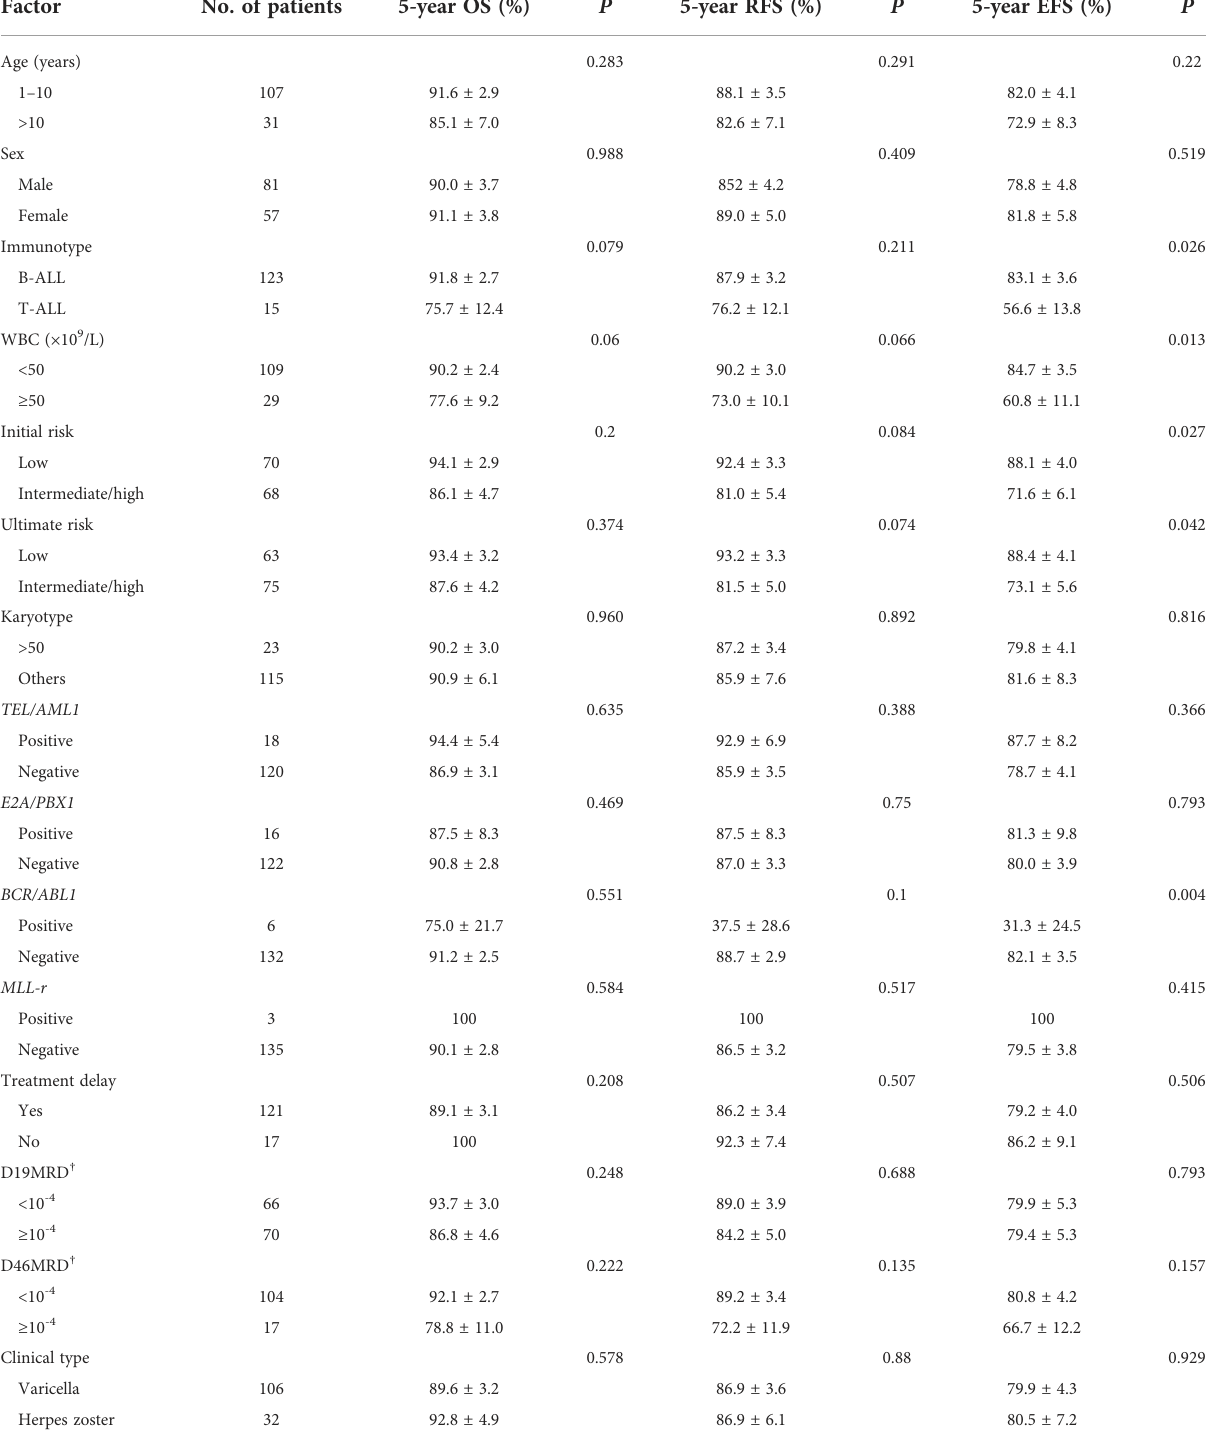
TABLE 5 Factors in fl uencing the 5-year overall survival, recurrence-free survival, and event-free survival in patients with varicella-zoster virus infection.